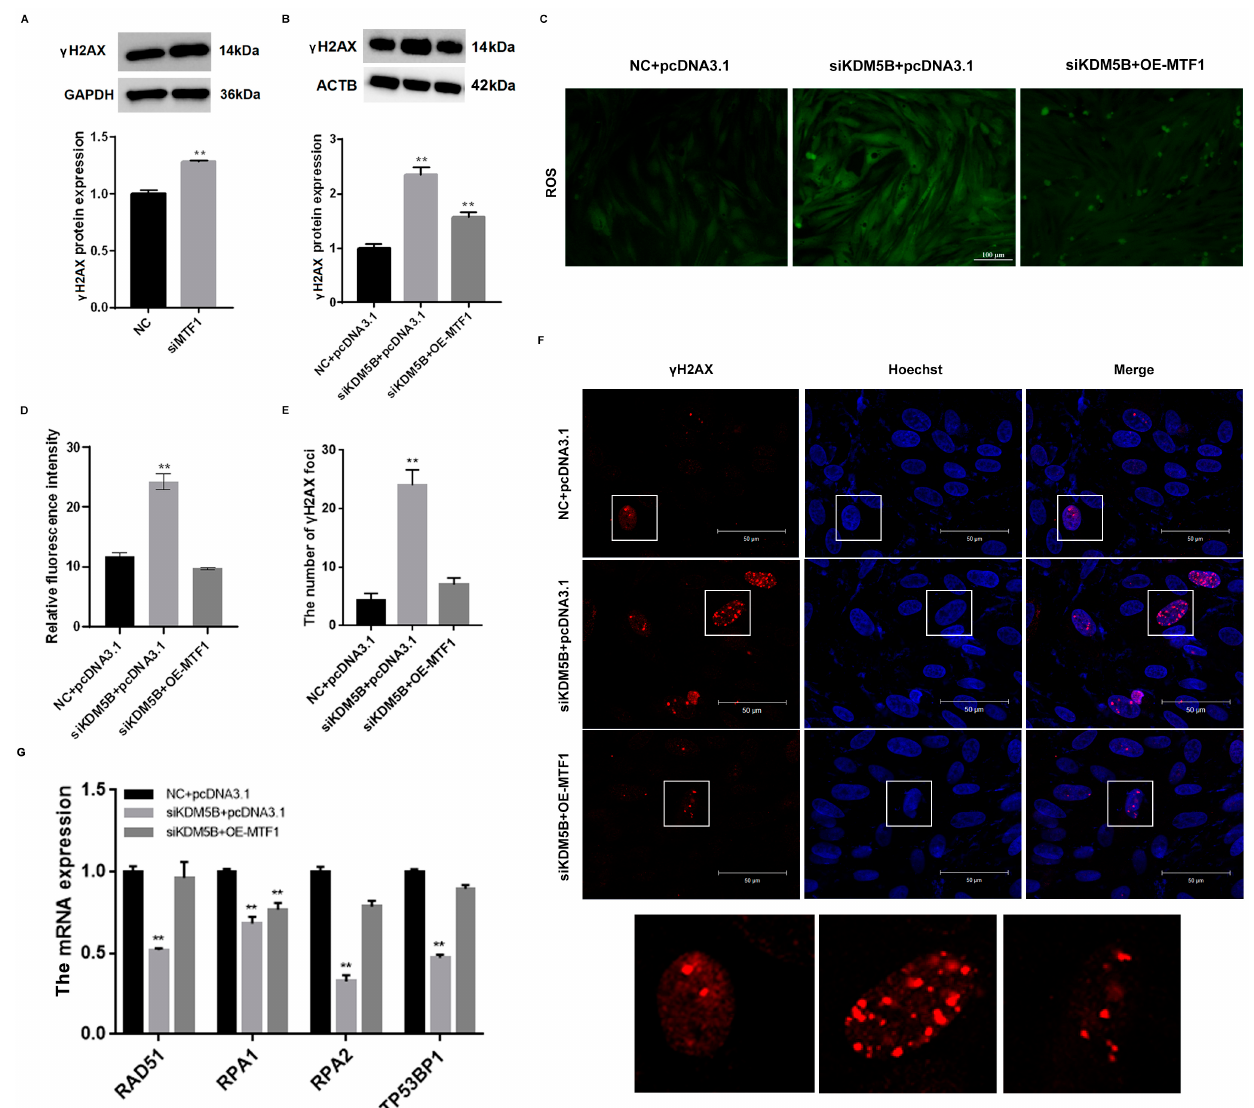
Figure 7. KDM5B inhibits DNA damage in GCs via MTF1 . ( A ) Protein expression of γ H2AX significantly increases after the knockdown of MTF1. ( B ) Protein expression of γ H2AX increases significantly in the KDM5B knockdown GCs and falls back after the simultaneous knockdown of KDM5B and overexpression of MTF1. ( C , D ) ROS level increases in the KDM5B knockdown GCs and falls back after the simultaneous knockdown of KDM5B and overexpression of MTF1. ( E , F ) γ H2AX immunofluorescence results show increasing DNA DSB sites in the KDM5B knockdown GCs, and DNA DSB sites decrease significantly after the simultaneous knockdown of KDM5B and overexpression of MTF1. ( G ) mRNA expressions of RAD511, RPA1, RPA2 and TP53BP1 significantly decrease after the knockdown of KDM5B and fall back after the simultaneous knockdown of KDM5B and overexpression of MTF1. ** means p <